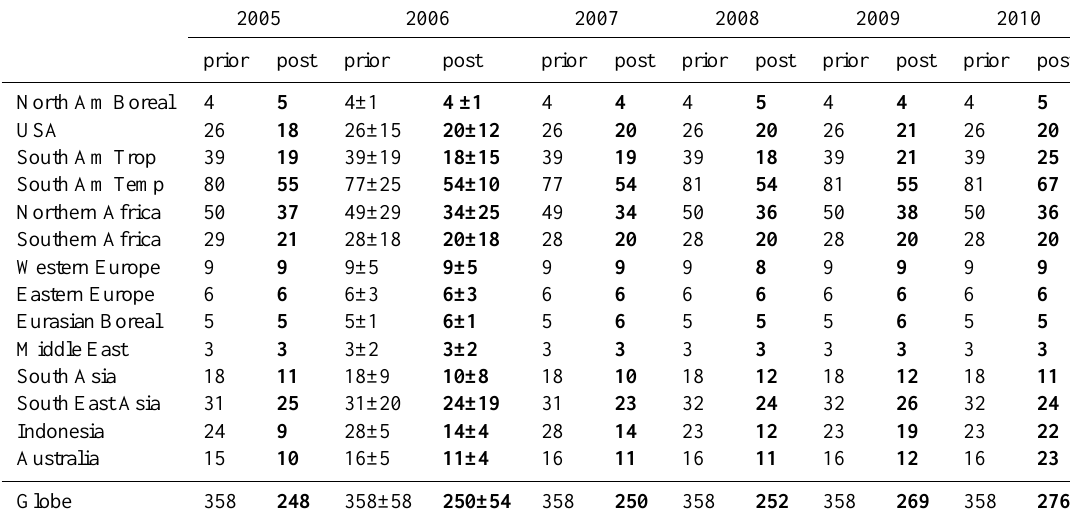
Table 1. Total 3-D HCHO production by NMVOC for years 2005 to 2010 before inversion and after inversion , for 14 continental regions and for the globe in TgHCHOyr − 1 . All budgets correspond to a 12-month period. The uncertainty of the inverted fluxes for 2006 are computed by a Monte-Carlo